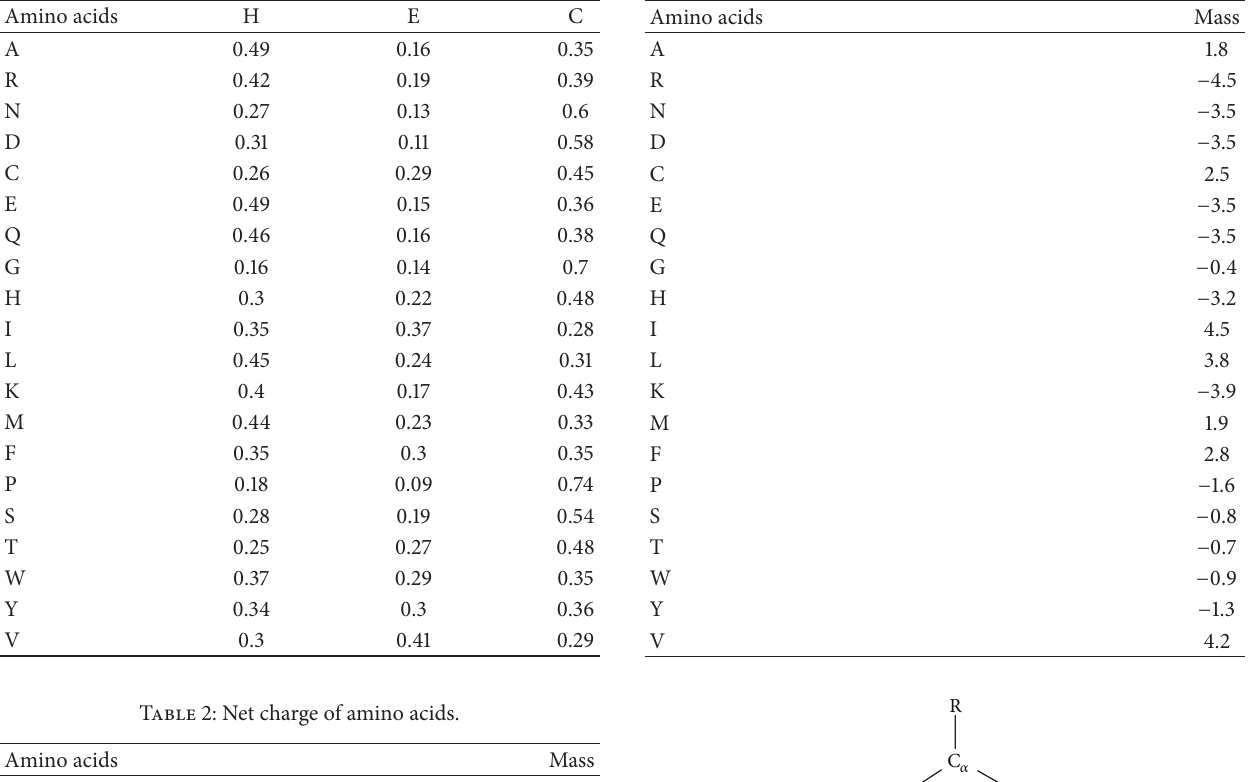
Table 1: Conformation parameters for each amino acid in a data set.